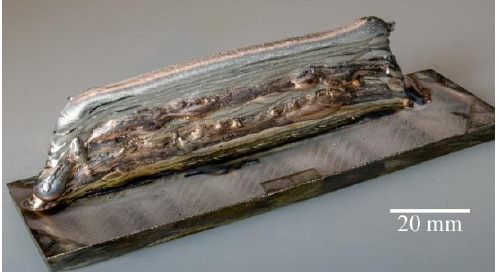
Figure 2. Vertical walls of “SS–Cu–SS–Cu–SS” were manufactured using copper and steel wires by the method of electron beam additive manufacturing.